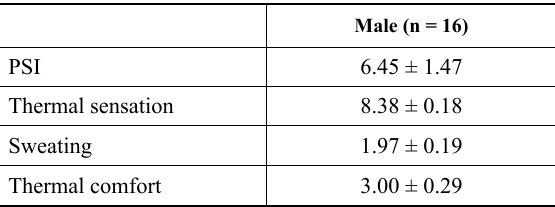
Table 2. Physiological strain index (PSI) and subjective ratings